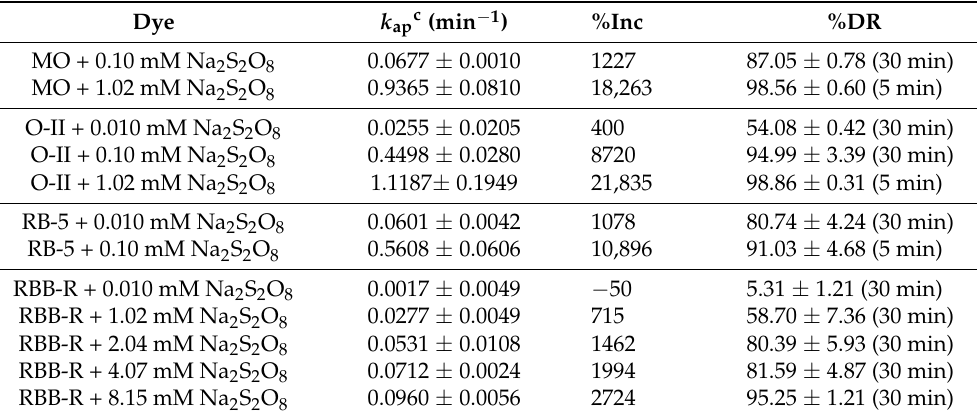
Table 3. Apparent first-order rate constant, percentage of the rate constant when the catalyst is present, and percentage of dye discoloration of the UV + S 2 O 82 − AOP of dyes (the standard deviations of at least three independent repetitions are shown). In parentheses, the reaction time necessary to achieve the percentage of dye removal is shown. The fitting of the integrated first-order kinetics resulted in R 2 >